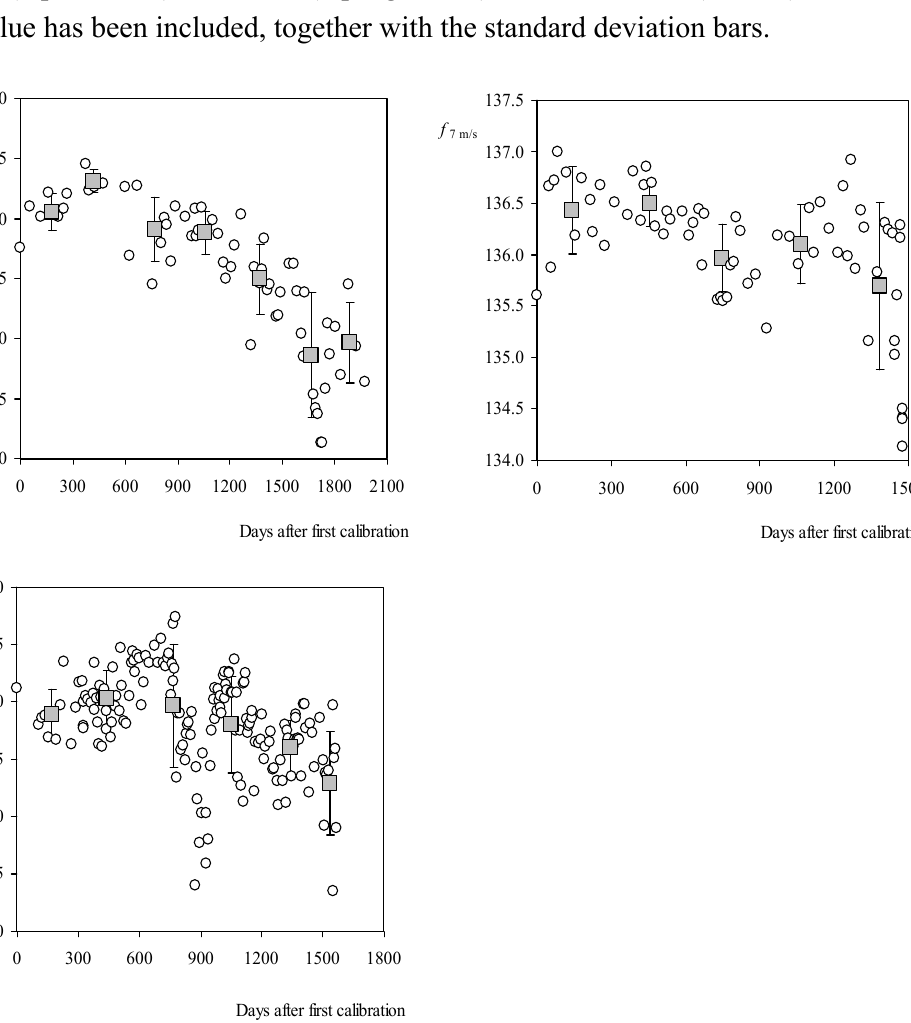
, as a function of 7m/s